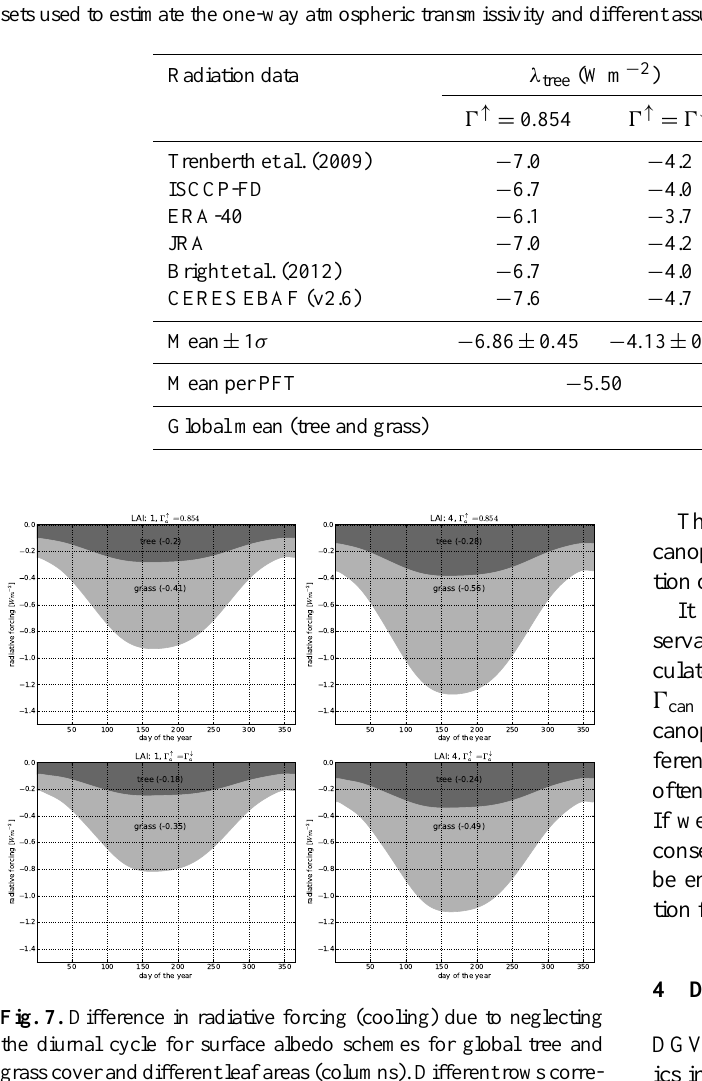
Table 3. Radiative forcing sensitivity ( ∂ RF /∂1α ) for different radiation data sets as derived from Eq. (19) for different global radiation data sets used to estimate the one-way atmospheric transmissivity and different assumptions about the calculation of 0 ↑ .